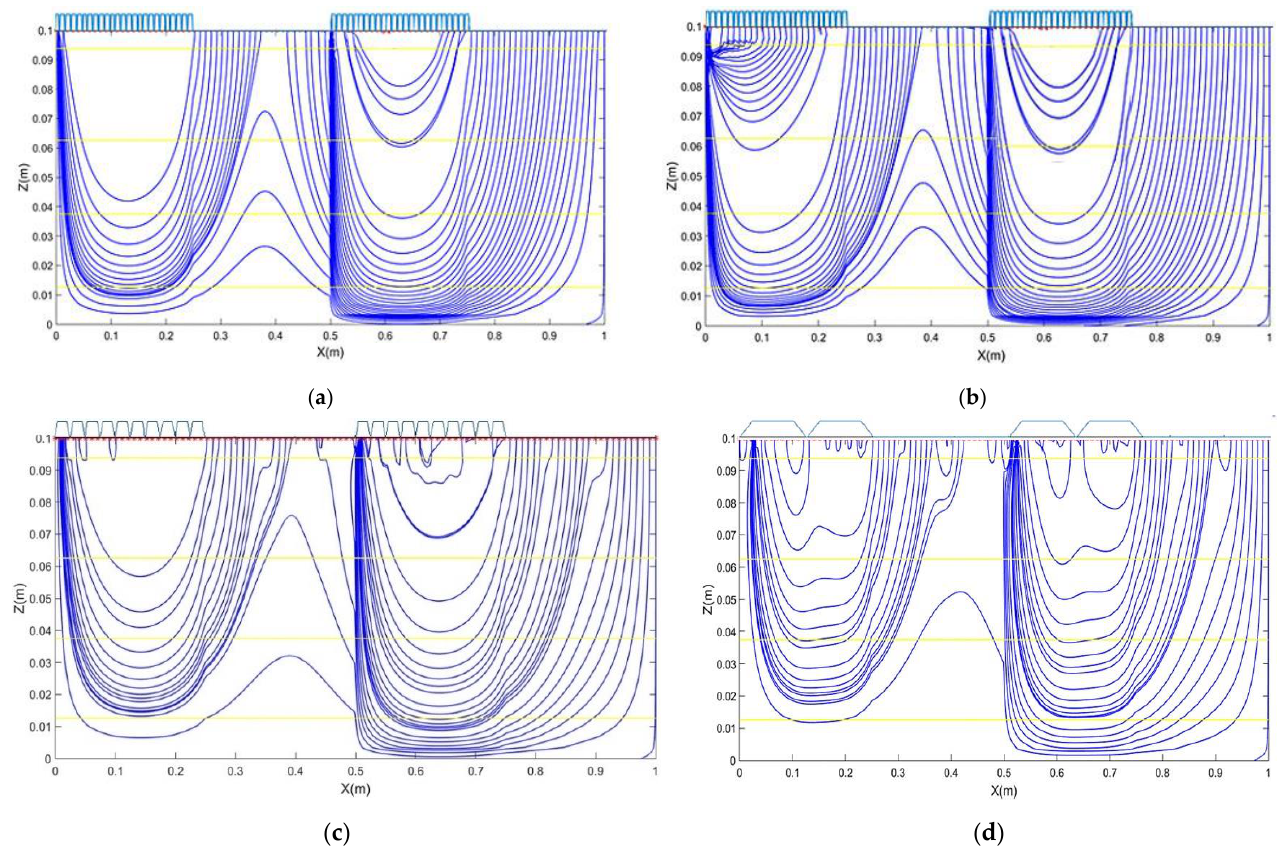
Figure 14. Distribution of streamlines for model set ups gpt8 × 10 ( a ) and gpt30 × 10 ( b ). Height variation in gravel pieces influences the number of streamlines generated from the same seeding locations. Gravel portions were shown using a rectangular block on the top of the figure distribution of streamlines for model set ups gpt5 × 25 ( c ), and gpt5 × 125 ( d ) resulted from the variation in base width of the gravel piece.